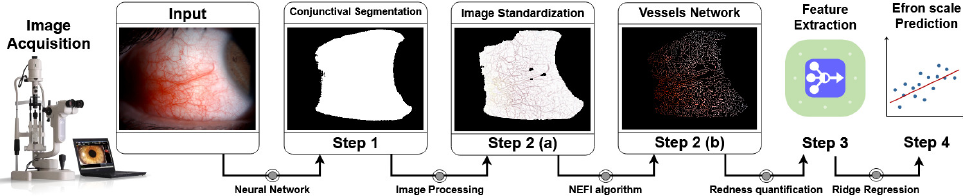
Figure 1. Schematic representation of the pipeline. ( Step 1 ) The image acquired by the slit lamp is used as input for the Neural Network (Mobile U-Net) model for the segmentation of the conjunctival area. The model was trained using manually annotated images validated by experts. ( Step 2 ( a )) Focusing on the conjunctival area the image is standardized using a brighter-correction algorithm given by a combination of median filters and background subtraction. ( Step 2 ( b )) The image standardization helps us to remove possible artifacts and color issues related to the non-rigid image acquisition procedure. The processed image is used as input for the vessels network segmentation algorithm given by a tuned implementation of the NEFI algorithm. ( Step 3 , 4 ) Starting from the vessels’ network image, a set of features for the quantification of the conjunctival redness are extracted and used for the development of a predictive model. The full set of steps are performed automatically and thus without any human